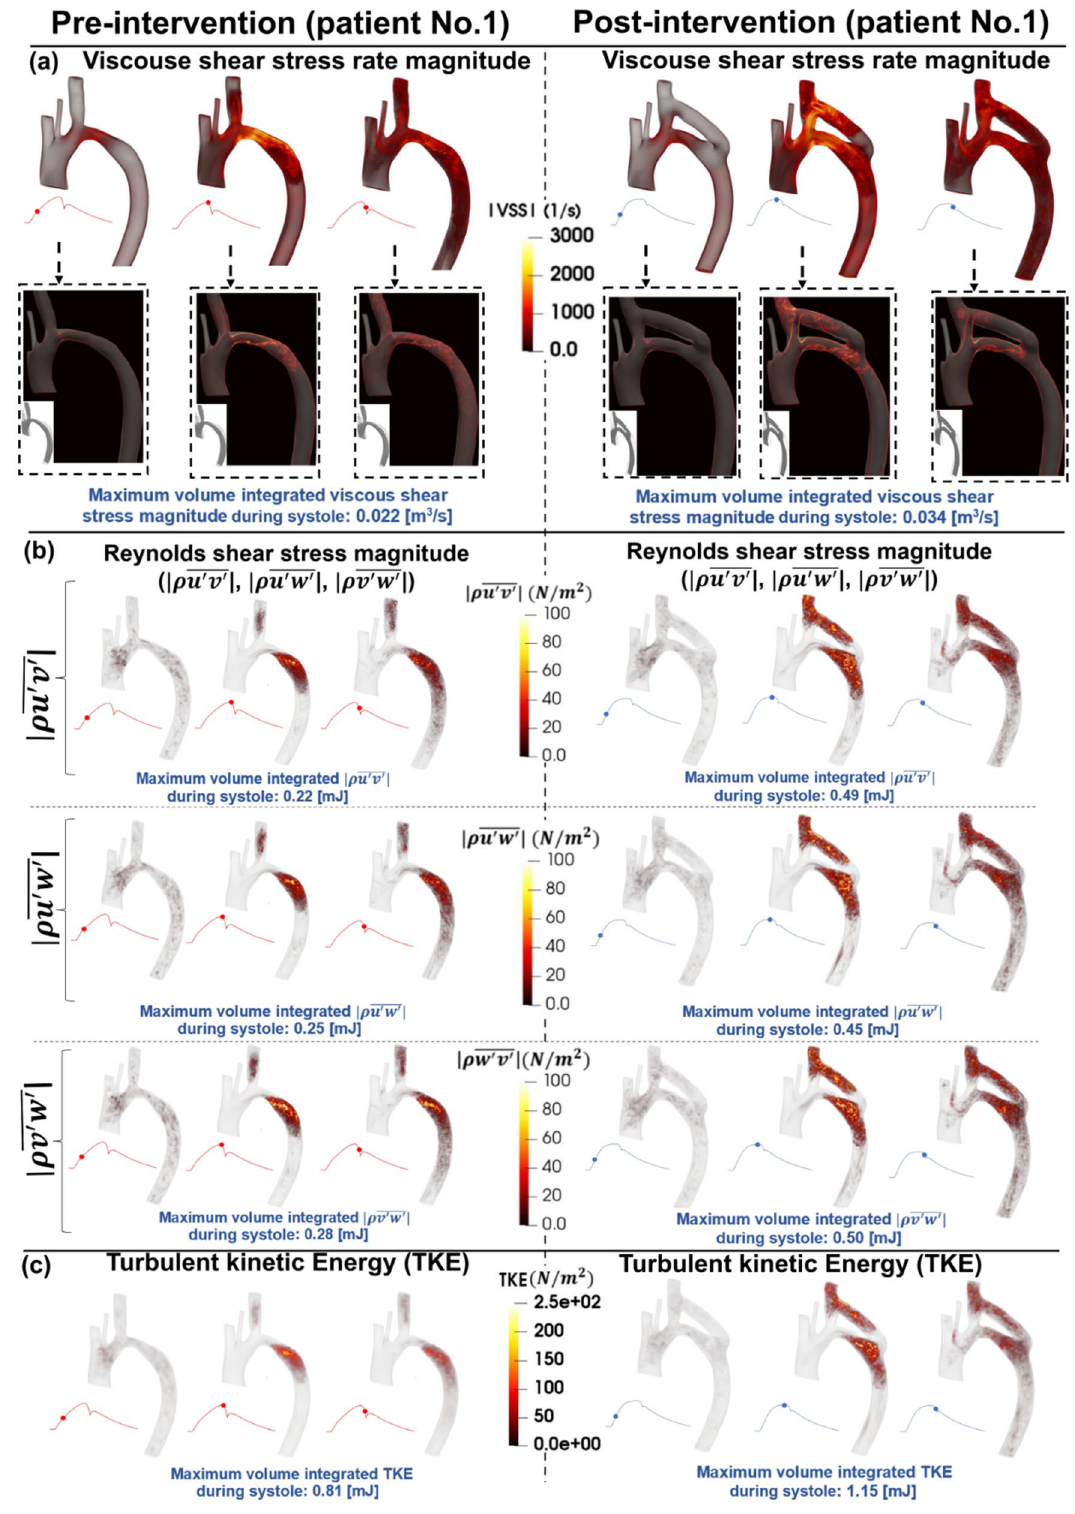
Figure 4. Flow modeling in Patient No. 1 in pre and post intervention status. ( a ) Viscous shear stress (VSS) magnitude; ( b ) Computed Reynolds Shear stress ( ρ u ′ v ′ , ρ u ′ w ′ and ρ w ′ v ′ ) magnitude; ( c ) Turbulent kinetic u ′ 2 + v ′ 2 + w ′ 2 energy (TKE), computed as 1 2 ρ , where u, v, w and ρ correspond to the three components of the instantaneous velocity vector and density. The bar and prime denote the ensemble averaged and fluctuating (cid:30) (cid:31) components,